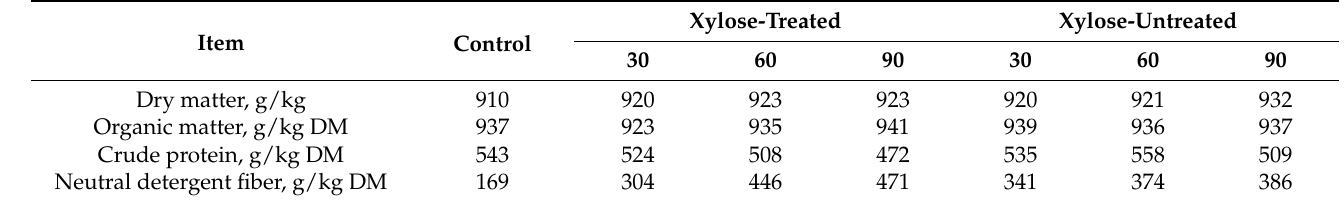
Table 2. Chemical composition of experimental ingredients of Experiment 2—conventional oven.